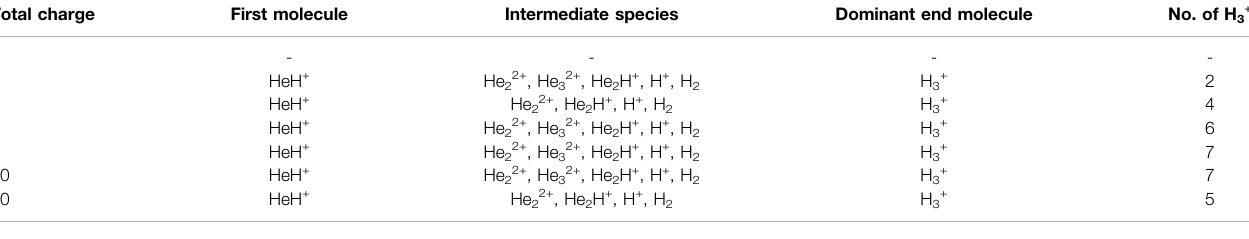
TABLE 1 | AINR simulations with 30 He atoms and 30 H atoms: different entries represent the variation of the total positive charge of the system – by even numbers. Total charge First molecule